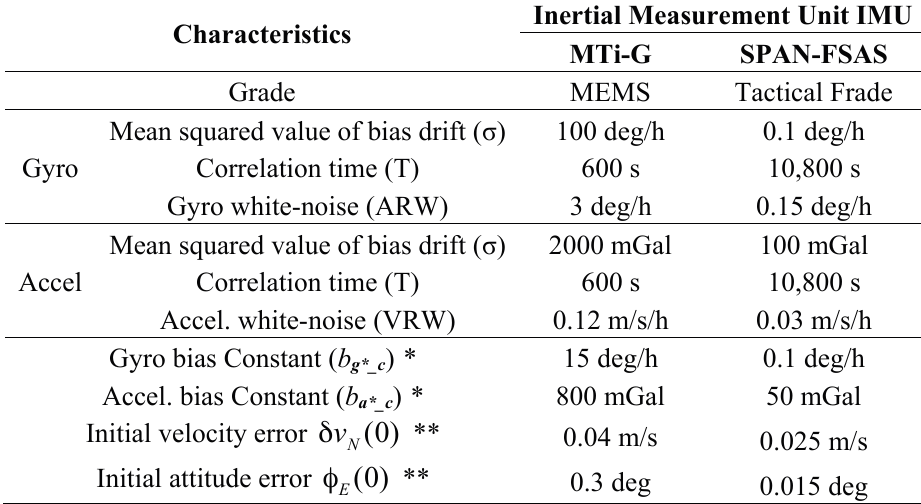
Table 1. Specifications of typical inertial measurement units